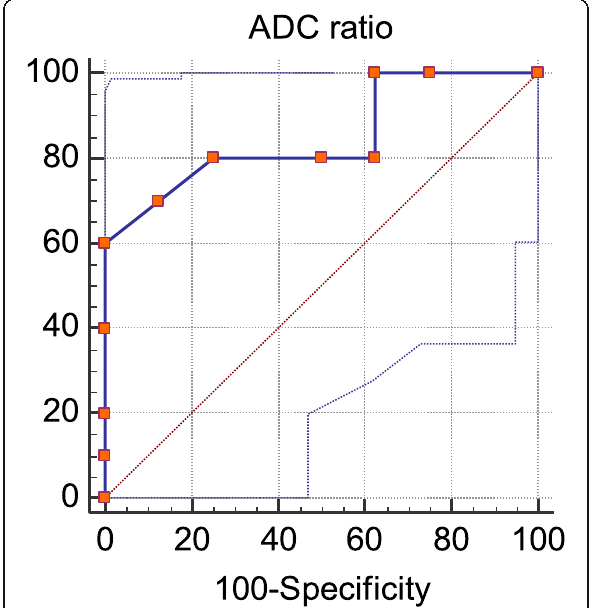
Fig. 10 ROC curve illustrates AUC, sensitivity, and specificity of ADC ratio in diagnosis of ependymoma